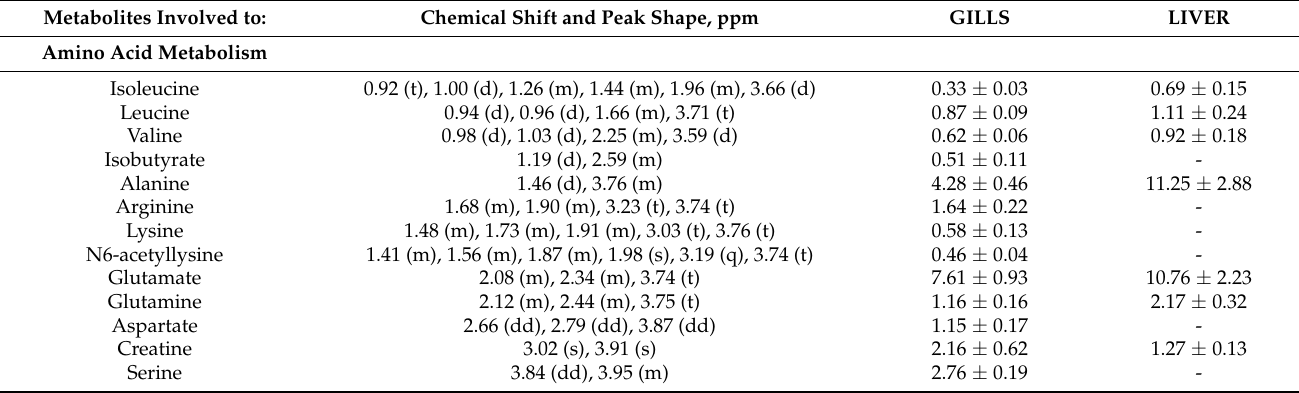
Figure 2. Representative 1-D 500 MHz 1 H NMR spectra of the gills and liver of golden grey mullet ( Chelon auratus ) that were collected from SJ. Keys: (1) taurocholic acid, (2) leucine, (3) isoleucine, (4) valine, (5) isobutyrate, (6) lactate, (7) alanine, (8) unknown resonance #1, (9) lysine, (10) arginine, (11) acetate, (12) N6-acetyllysine, (13) glutamate, (14) glutamine, (15) acetone, (16) glutathione, (17) succinate, (18) aspartate, (19) creatine, (20) malonate, (21) choline, (22) phosphocholine, (23) glycerophosphocholine, (24) taurine, (25) unknown resonance #2, (26) glycine, (27) serine, (28) betaine, (29) inosine, (30) glucose, (31) glycogen, (32) UDP-glucose, (33) uracil, (34) uridine, (35) fumarate, (36) tyrosine, (37) unknown resonance #3, (38) phenylalanine, (39) hypoxanthine, and (40) niacinamide. Table 1. 1 H NMR measurements (mM) as means ± SD of metabolites that were found in the gills and liver of golden grey mullet ( C. auratus ) that were collected from the reference area (s: singlet; d: doublet; t: triplet; q: quartet; dd: doublet of doublets; dt: doublet of triplets; dq: doublet of quartets; m: multiplet).